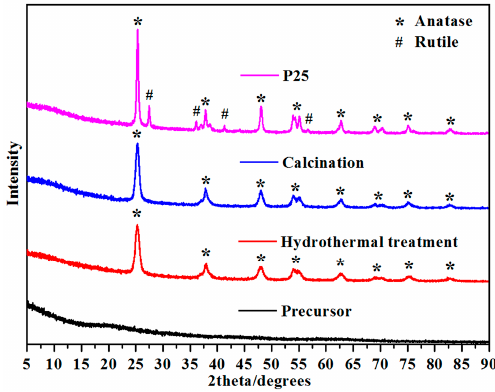
Figure 2. PXRD patterns of the precursor bead, mesoporous spherical TiO 2 after hydrothermal treatment, mesoporous spherical TiO 2 after calcination, and P25 TiO 2 .